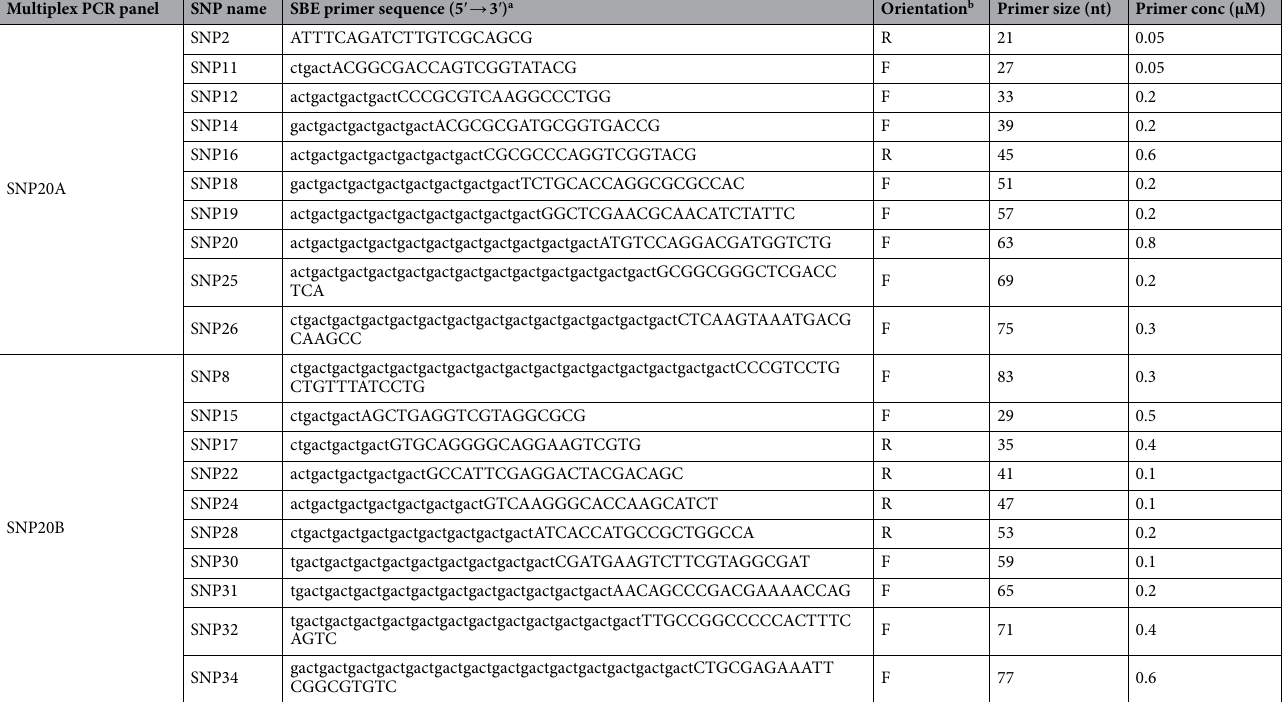
Table 3. Single-base extension (SBE) primers used for the multiplex PCR panels, SNP20A and SNP20B. a The sequences in uppercase and lowercase represent the target specific sequence and neutral sequence, respectively. b Orientation of primer according to the genomic sequence of Bordetella pertussis Tohama: NC_002929.2. F forward; R